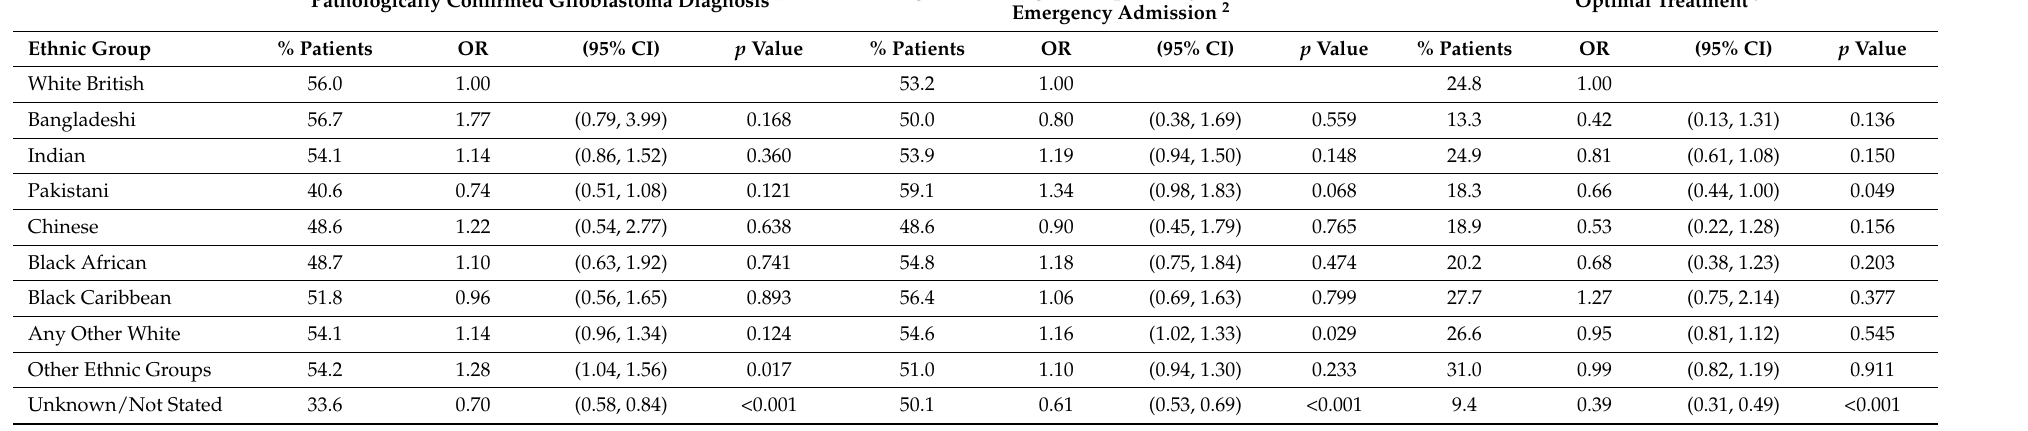
Table 4. Odds ratios of malignant primary brain tumour patients in England 2012–2017, by ethnicity, diagnosed with glioblastoma, diagnosed as emergency through hospital stay and receiving optimal treatment. Percentage (%) of patients within each ethnic